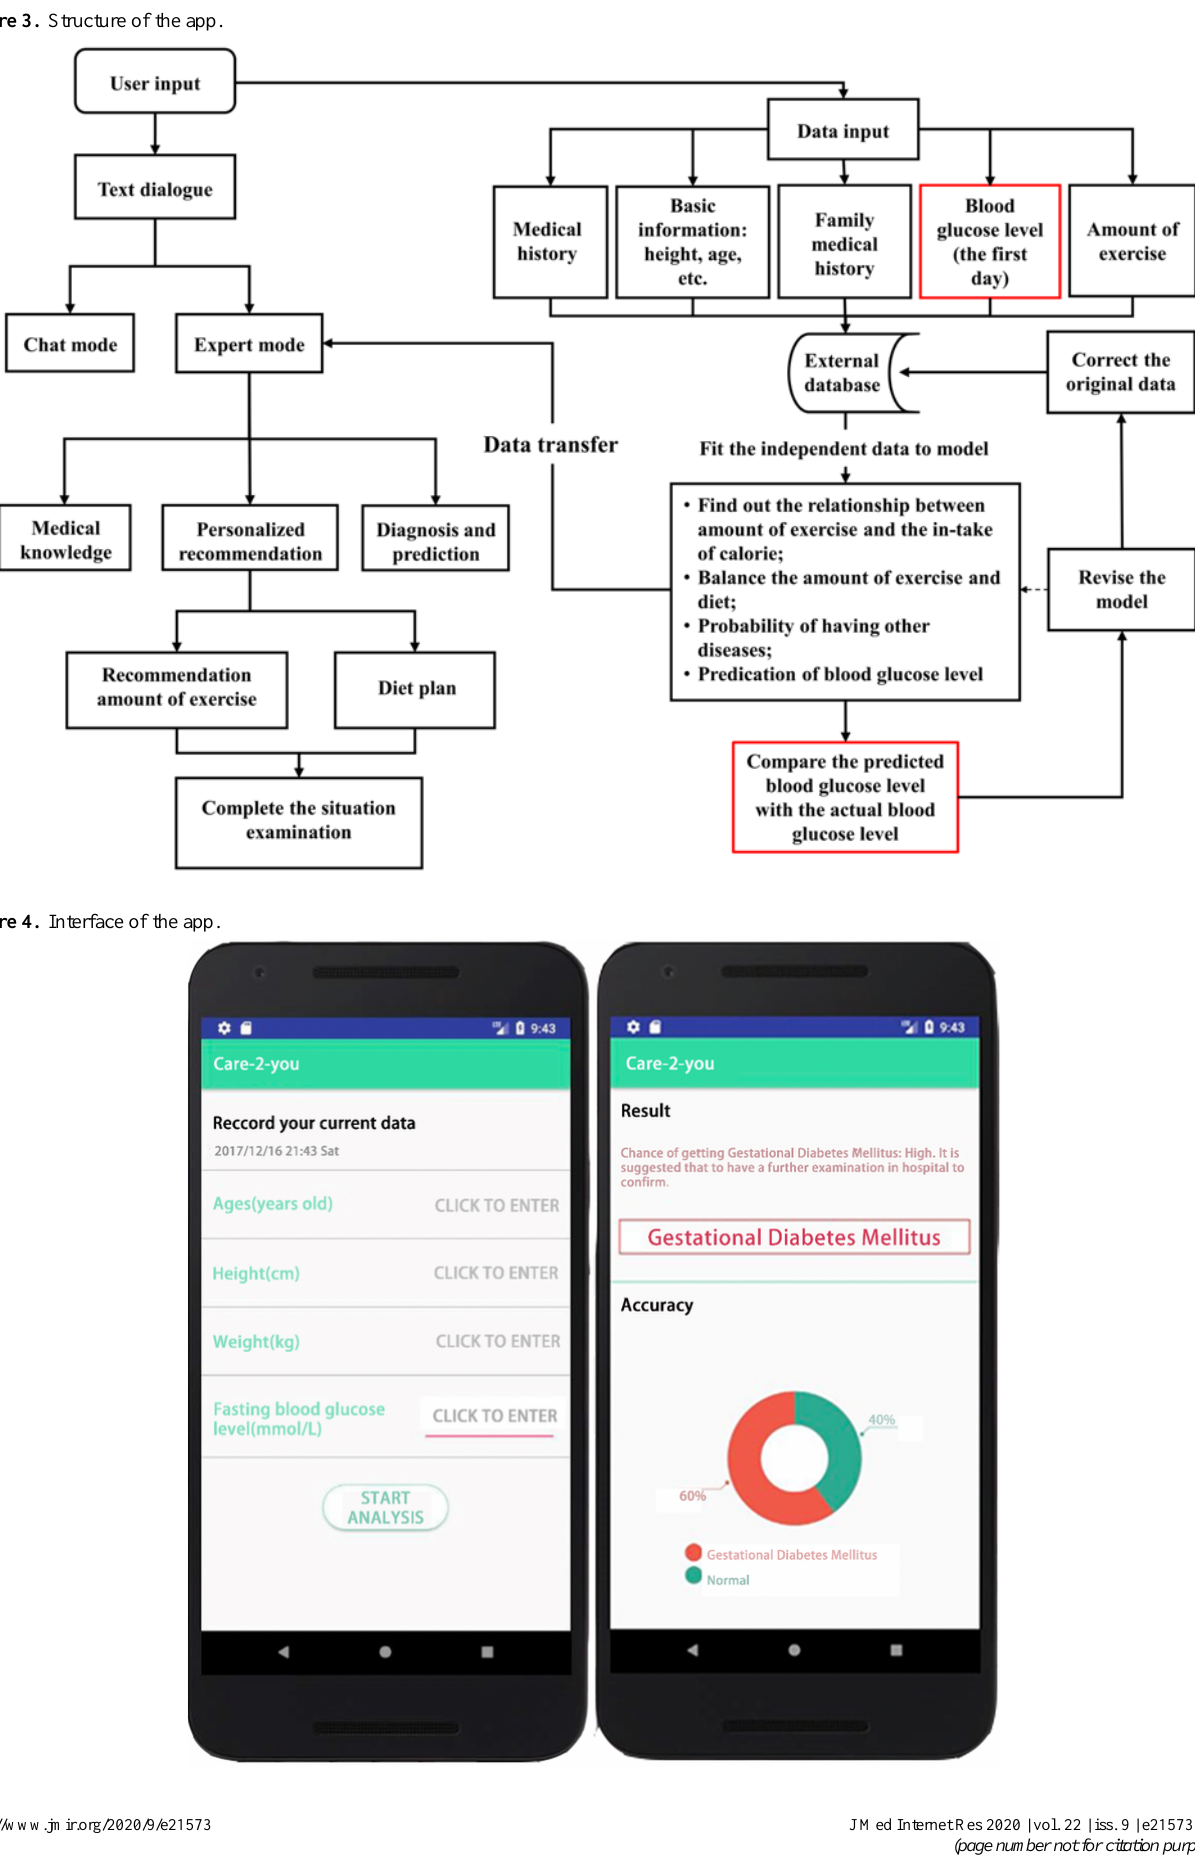
Figure 3. Structure of the app.